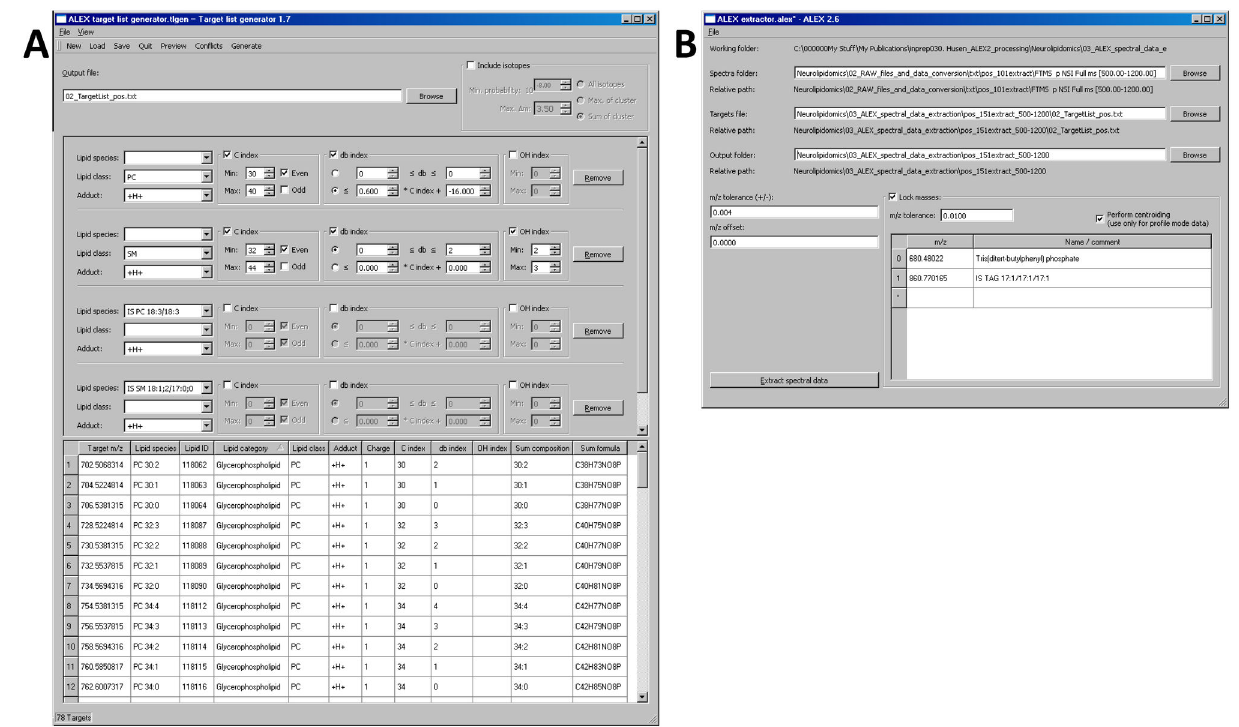
Figure 3. Screenshots of the ALEX target list generator and ALEX extractor. ( A ) The ALEX target list generator allows users to select lipid classes and species to be identified using criteria such as lipid class, adduction, C index, db index and OH index. Individual lipid species including internal standards can also be selected. The ALEX target list generator output is a .txt file with a shortlist of selected lipid species, respective m/z values and accessory lipid features. The ALEX target list generator also supports inclusion of isotope information that can be used for deisotoping and isotope correction [20] by applying algorithms within the auxiliary workflow. ( B ) The ALEX extractor identifies lipid species, exports intensity data and incorporates accessory lipid features. As input the ALEX extractor requires the location of spectral peak lists generated by the ALEX converter, a target list compiled by the ALEX target list generator and a location to deposit output files. The ALEX extractor features options to specify an m/z tolerance window for lipid identification, to apply a constant m/z offset to correct lipid searches for a constant FT MS calibration offset or to apply a lock mass adjustment routine that automatically corrects lipid searches for drifts in FT MS calibration. The automated lock mass adjustment routine requires specification of well-characterized and ubiquitous lock mass ions in order to estimate the FT MS calibration